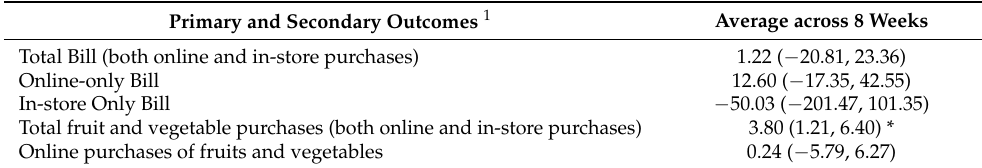
Table 4. Purchase Type—Association between how food was purchased online compared to in-store [reference] on total bill and fruit/vegetable